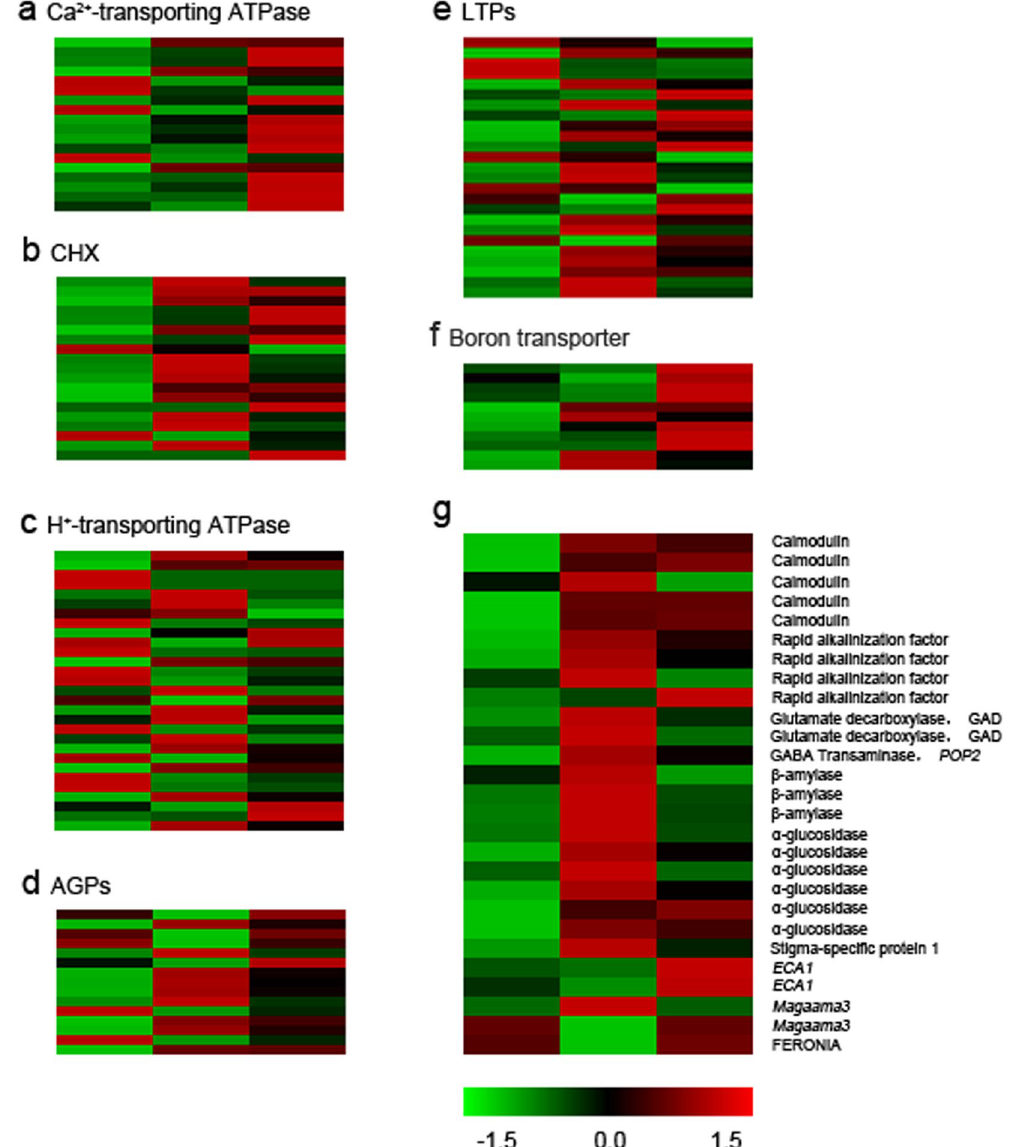
Figure 6. Genes related to pollen tube guidence. ( a ) Genes encoding Ca 2 + -transporting ATPase, ( b ) genes encoding CHX, ( c ) genes encoding H + -transporting ATPase, ( d ) genes encoding AGPs, ( e ) genes encoding LTPs, ( f ) boron transporter, ( g ) other related